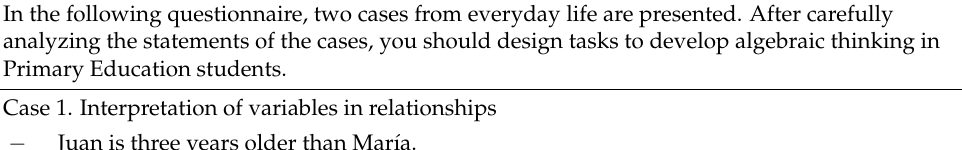
Table 1. Algebraic knowledge questionnaire for student